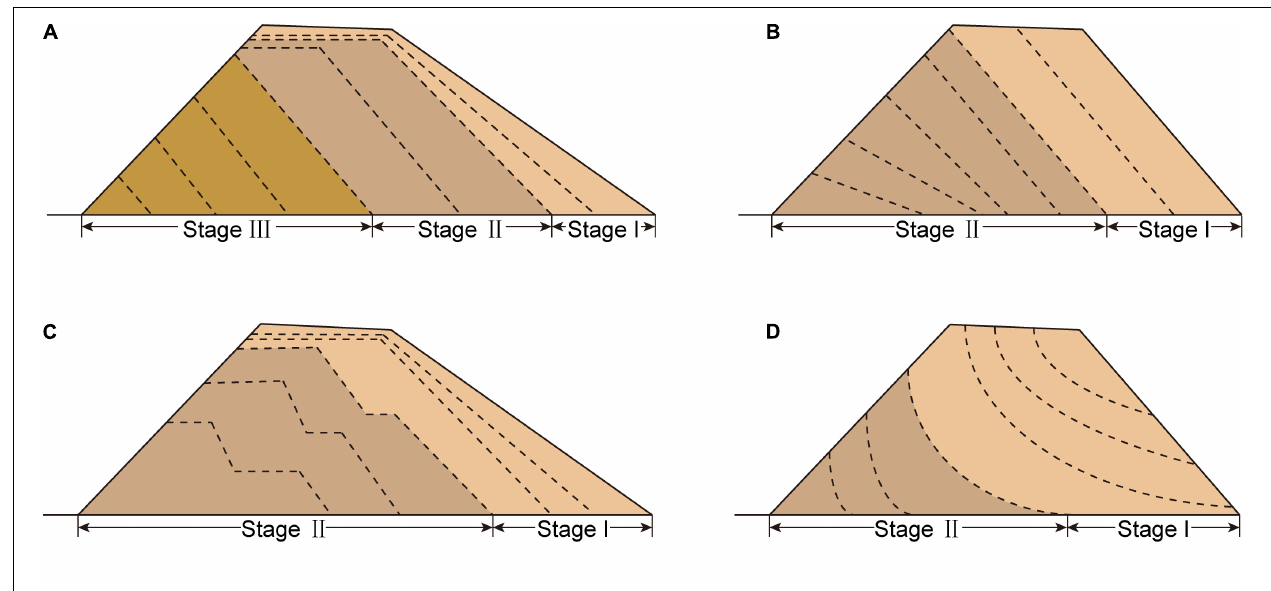
FIGURE 10 | Overtopping failure patterns of landslide dams: (A) downstream slope angle rapidly increases until a constant critical soil friction angle is achieved and then the angle is maintained to breach end; (B) downstream dam face is initially eroded with an slope parallel to the face, then the breach inverts slope, progressively flattening to a terminal value; (C) a stepped profile is first developed and then the retreating headcut maintains a slope near the internal friction angle of the dam material; and (D) a spindle-like failure process is observed along the flow